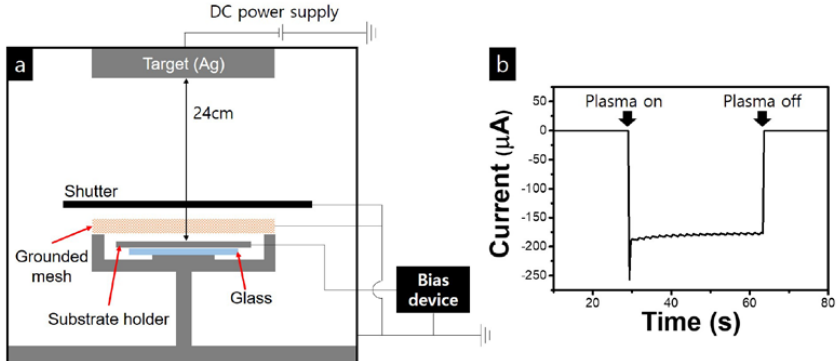
Figure 1. ( a ) Schematic of the DC sputtering system and ( b ) the current measured on the substrate holder at the plasma power of 200 W.